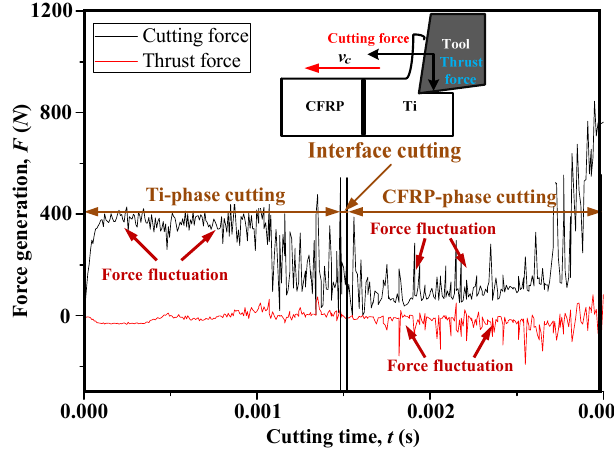
Figure 6. Evolution of the force generation versus cutting time when cutting hybrid CFRP/Ti composite ( v c = 40 m/min, f = 0.2 mm/rev and θ = 0°).